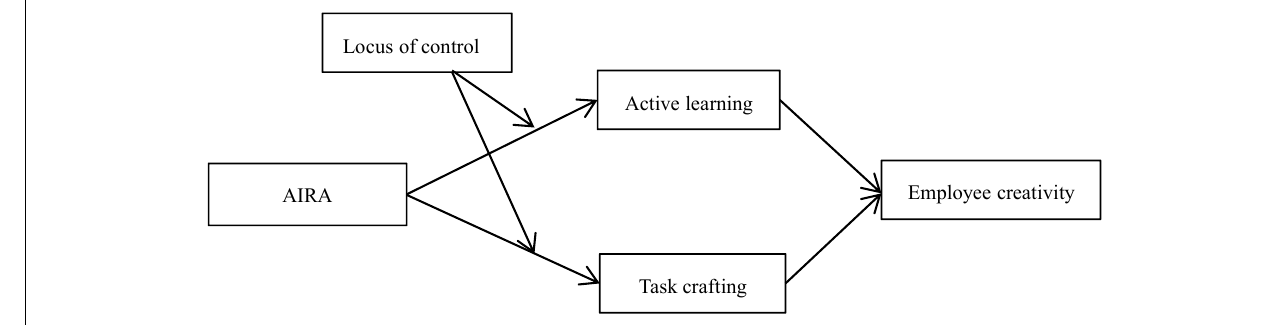
FIGURE 1 | Theoretical model. TABLE 1 | Sample